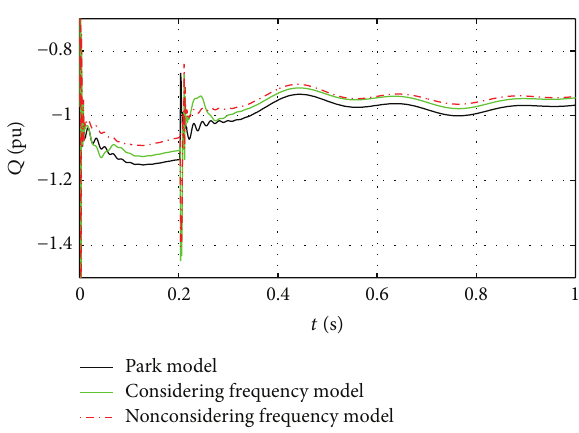
Figure 8: Active power of wind generator.